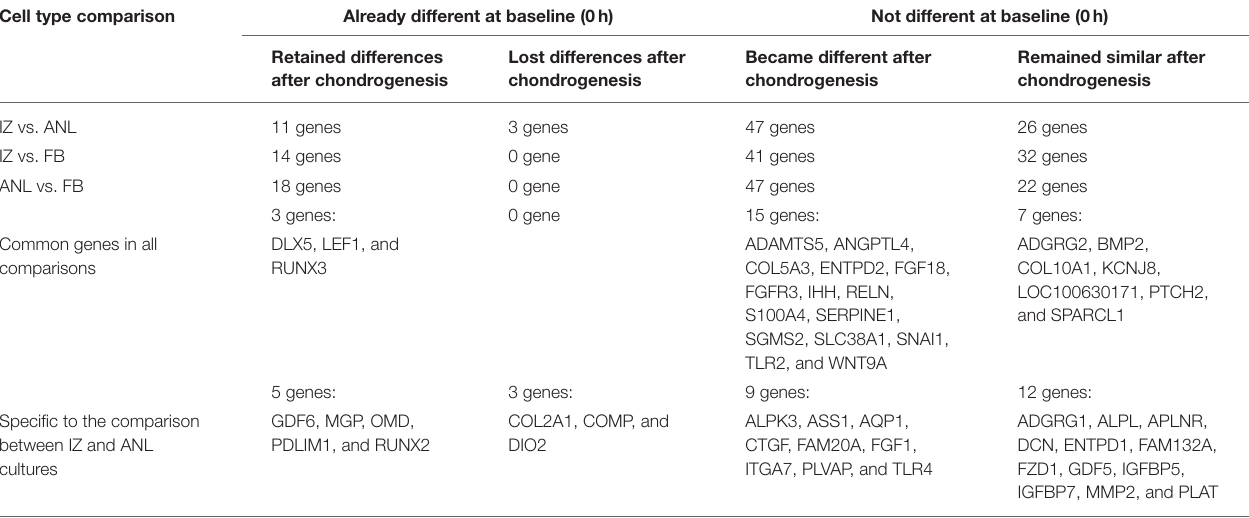
TABLE 2 | Four patterns of differential gene expression before and after inducing in vitro chondrogenesis. Cell type